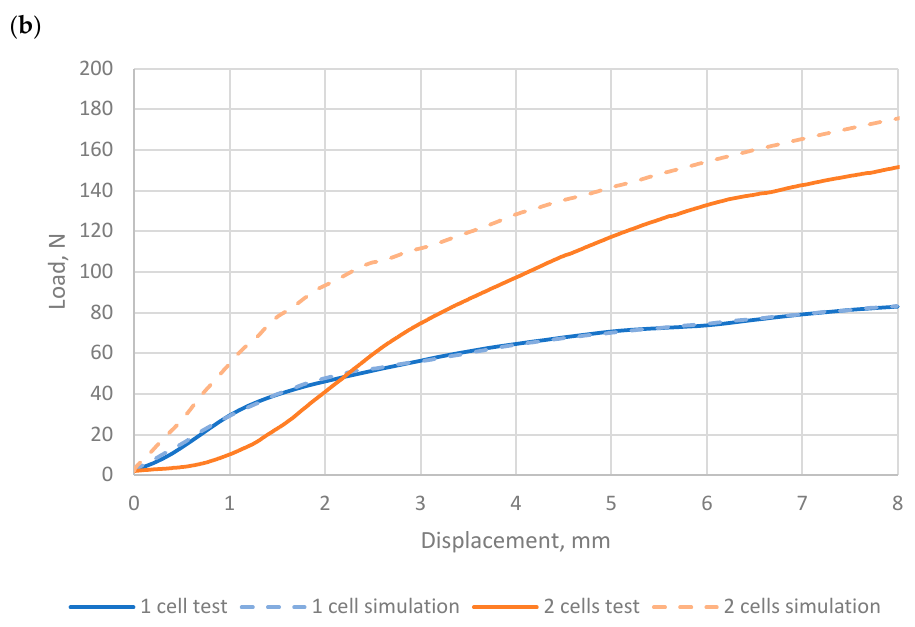
Figure 9. Comparison between the simulation and physical 3PB test data for ( a ) single and double cells bent around the X axis and ( b ) single and double cells bent around the Y axis.